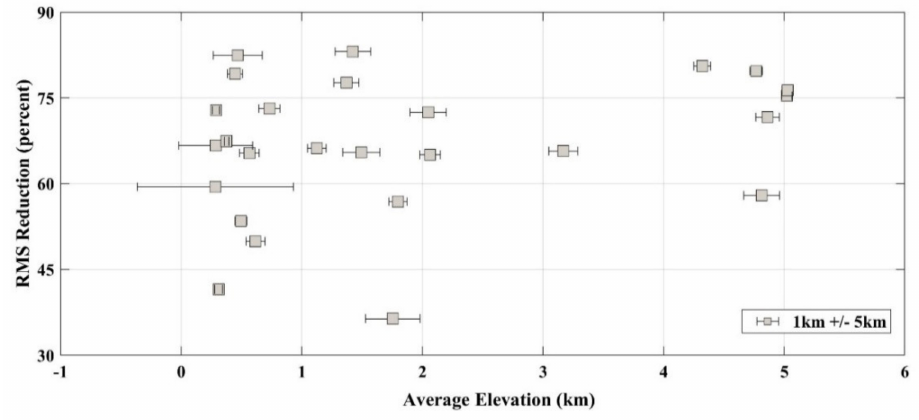
Figure 6. The RMS reduction after SSC vs. average & standard deviation of the local elevation. The X -axis has a unit of kilometer; the Y -axis is the percentage of RMS reduction; the error bar of each marker is scaled by 5